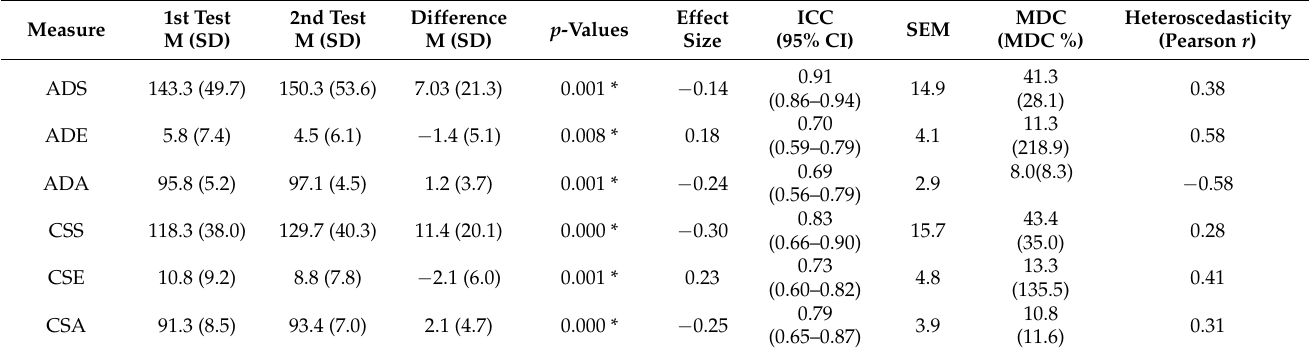
Table 2. Test–retest reliability of the RSAT (raw